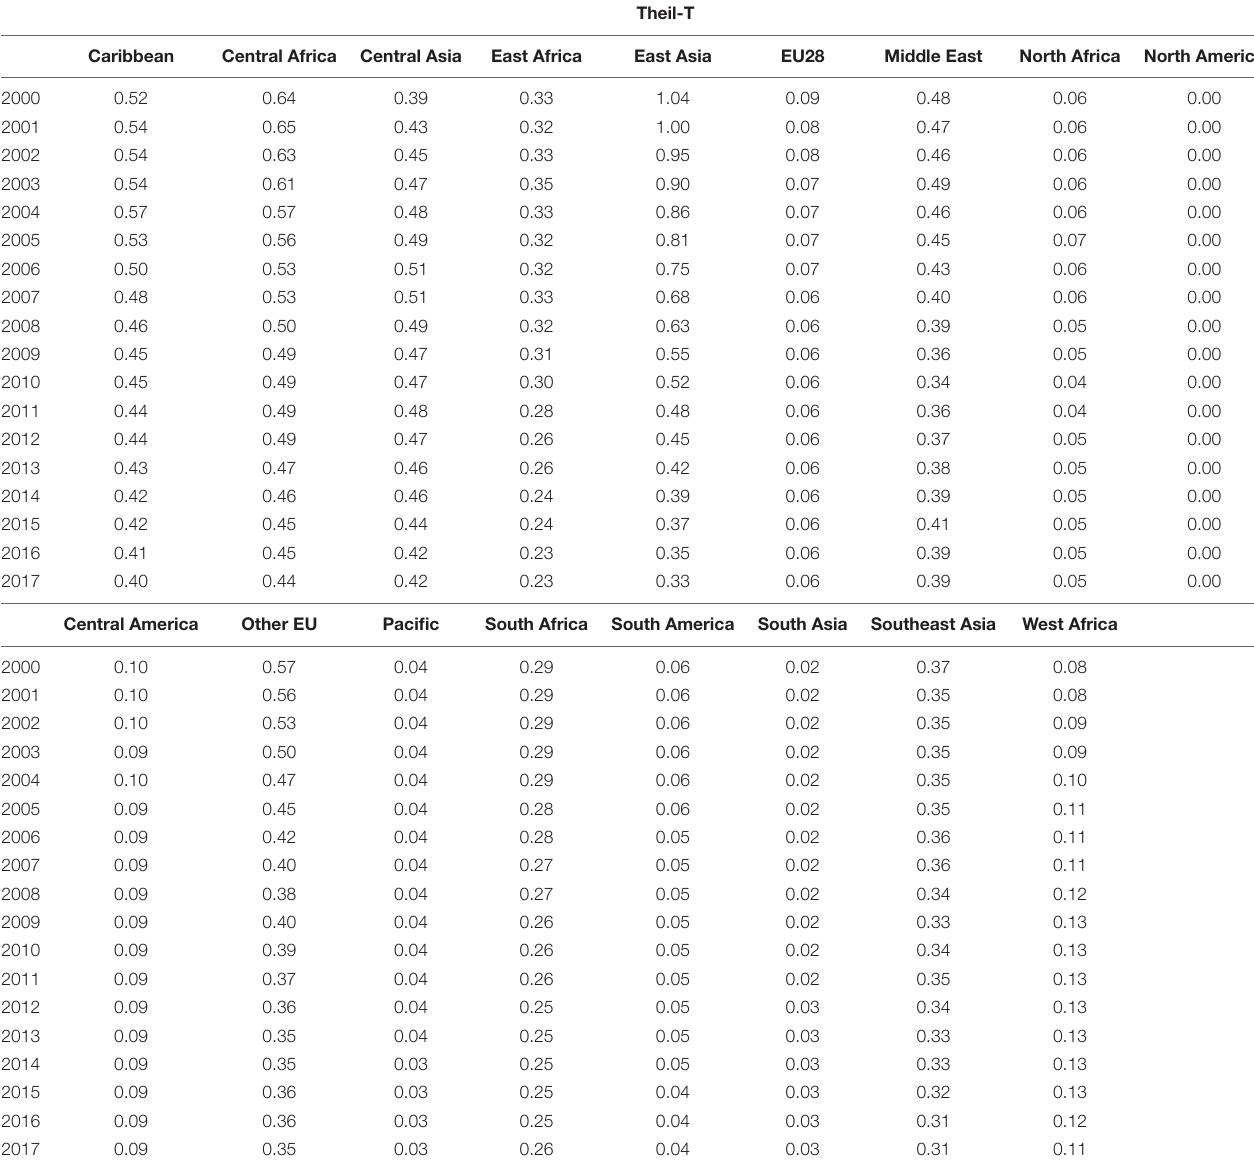
TABLE 5 | Income inequality (Theil-T) for 17 regional subgroups, 2000–2017.